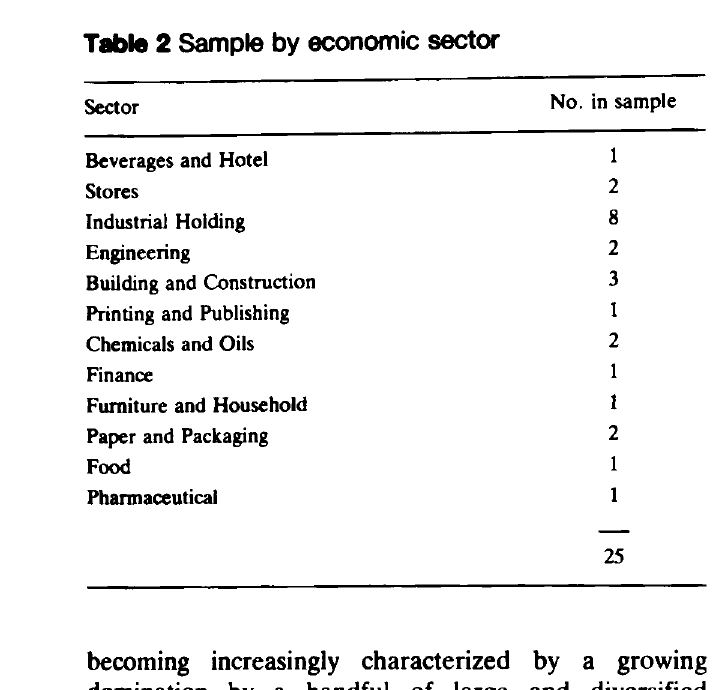
Table 2 Sample by economic